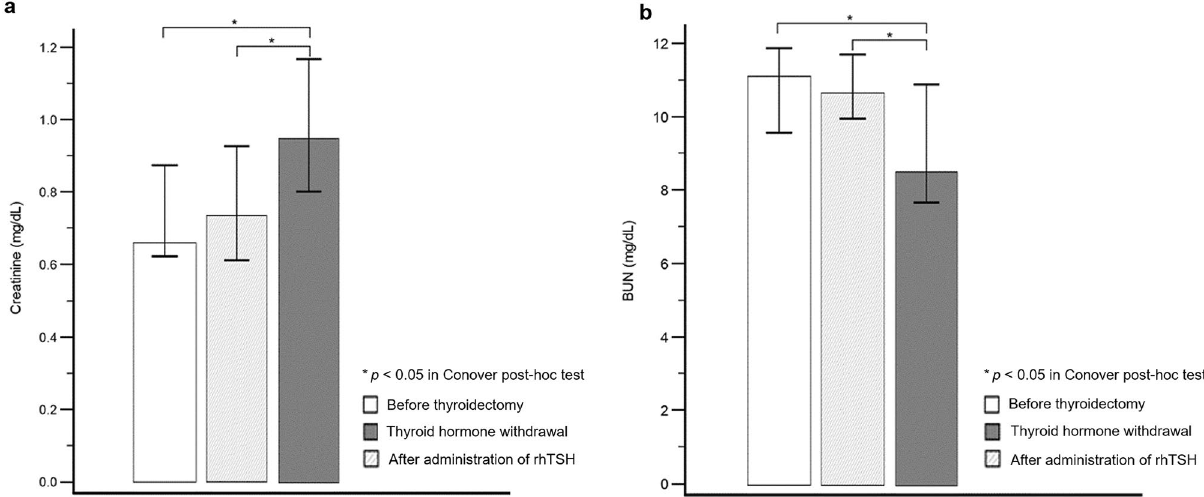
Figure 2. Comparison of renal parameters under each condition in the same patient group. ( a ) The Cr level was significantly higher after THW compared to that following rhTSH administration and before thyroidectomy (both p < 0.05 in Conover post-hoc test). However, the Cr level after rhTSH administration was not significantly different compared to that before thyroidectomy. ( b ) BUN after THW was significantly lower than that after rhTSH administration and before thyroidectomy (both p < 0.05 in Conover post-hoc test). BUN blood urea nitrogen, Cr creatinine, rhTSH recombinant human thyroid-stimulating hormone, THW thyroid hormone